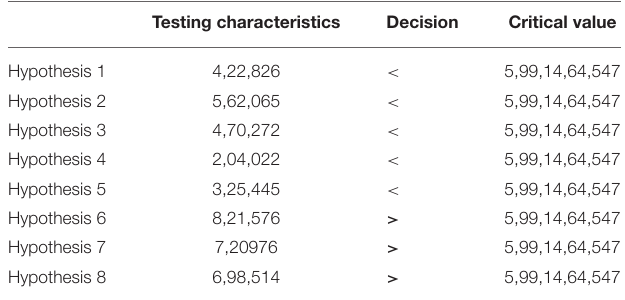
TABLE 3 | Results of the comparison of test characteristics and critical values during the statistical survey. Source: own processing. Testing